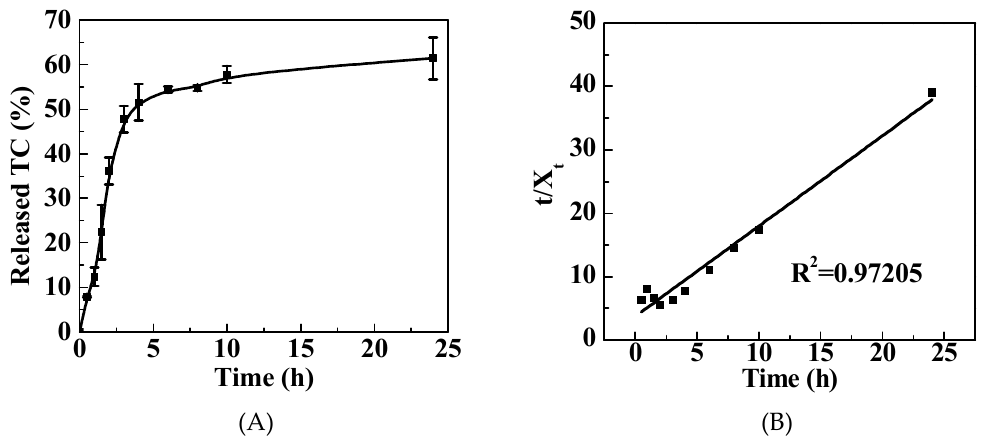
Figure 3. TC release behavior ( A ) and the release kinetic model ( B ) of the TC/PG nanocomposites.